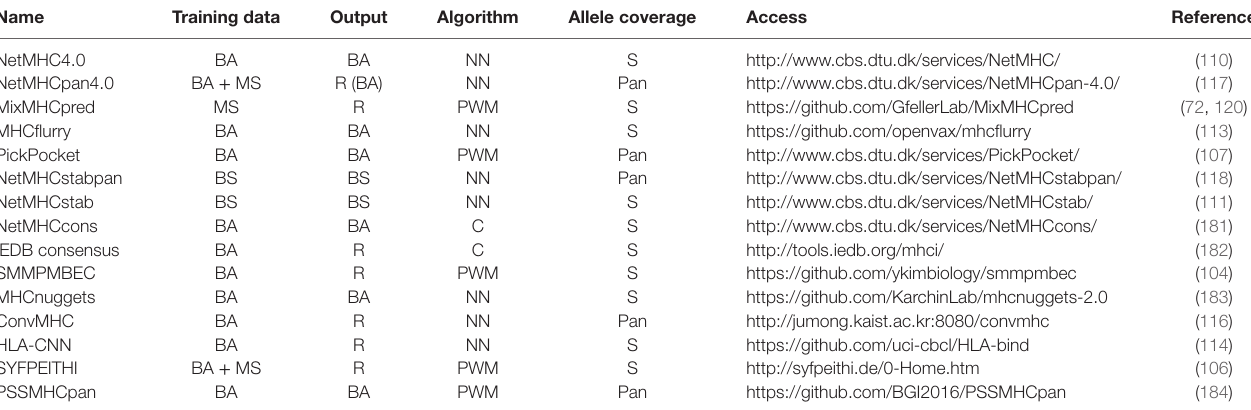
TABLe 1 | Summary of some of the most recent or most widely used human leukocyte antigen (HLA)-I predictors with available web interface or code